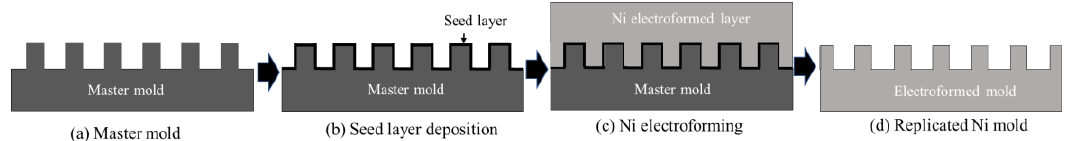
Figure 4. Schematic illustration of the fabrication of a Ni mold using electroforming: ( a ) master mold, ( b ) deposition of the conducting seed layer, ( c ) deposition of the Ni electroformed layer, and ( d ) removal of the Ni electroformed layer.